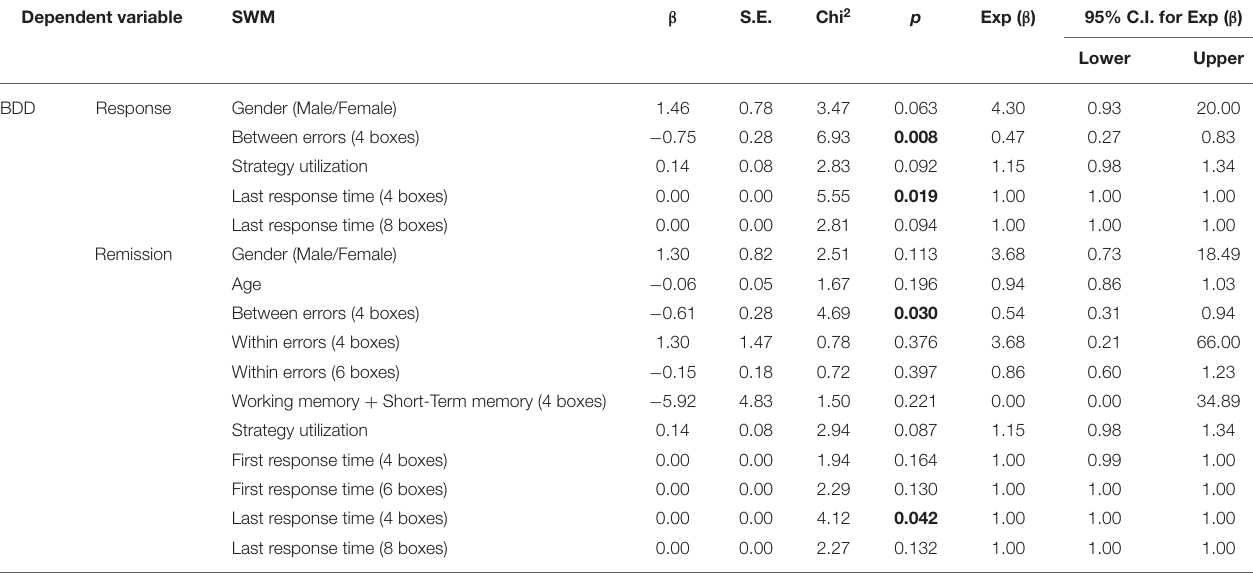
TABLE 6 | Binary logistic regression analysis: demographic and SWM predictors of response or remission. Dependent